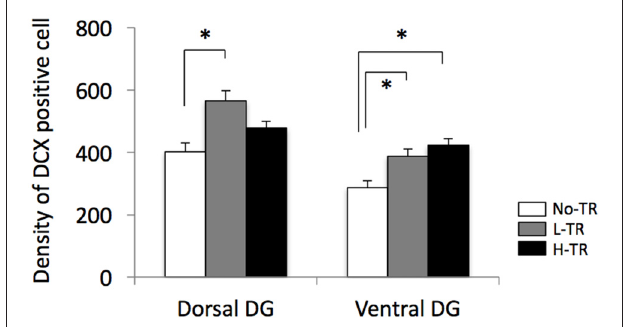
FIGURE 6 | Effects of 4 weeks of regular treadmill running at different intensities on expression of DCX positive cells in the dorsal and ventral hippocampus. ∗ p < 0.05 vs.